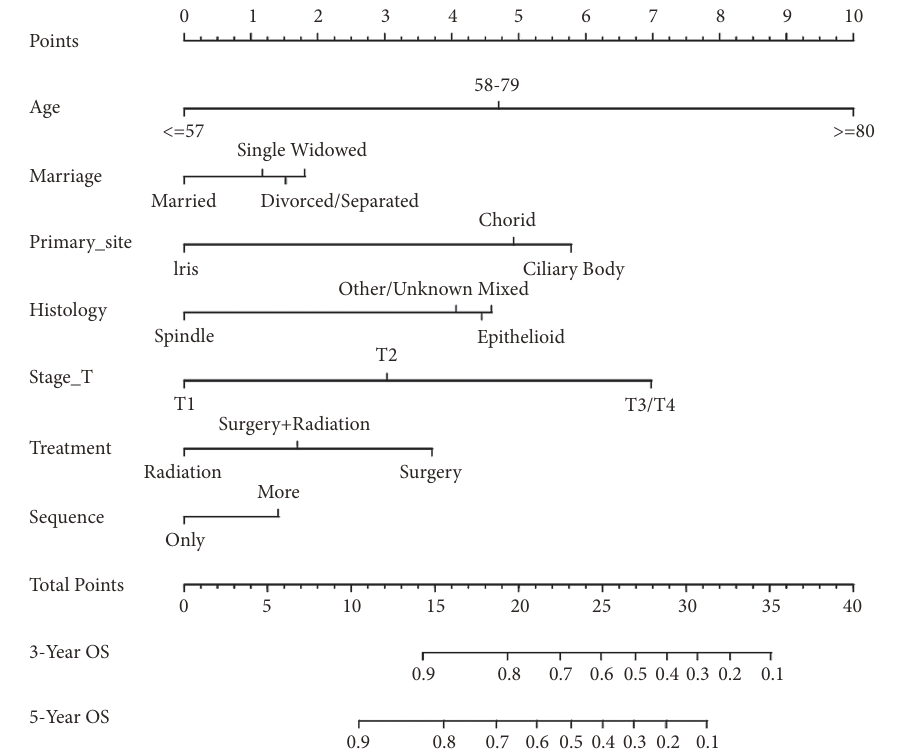
Figure 2: Nomograms for the prediction of the 3- and 5-year OS values for patients with UM without metastases. OS: overall survival.